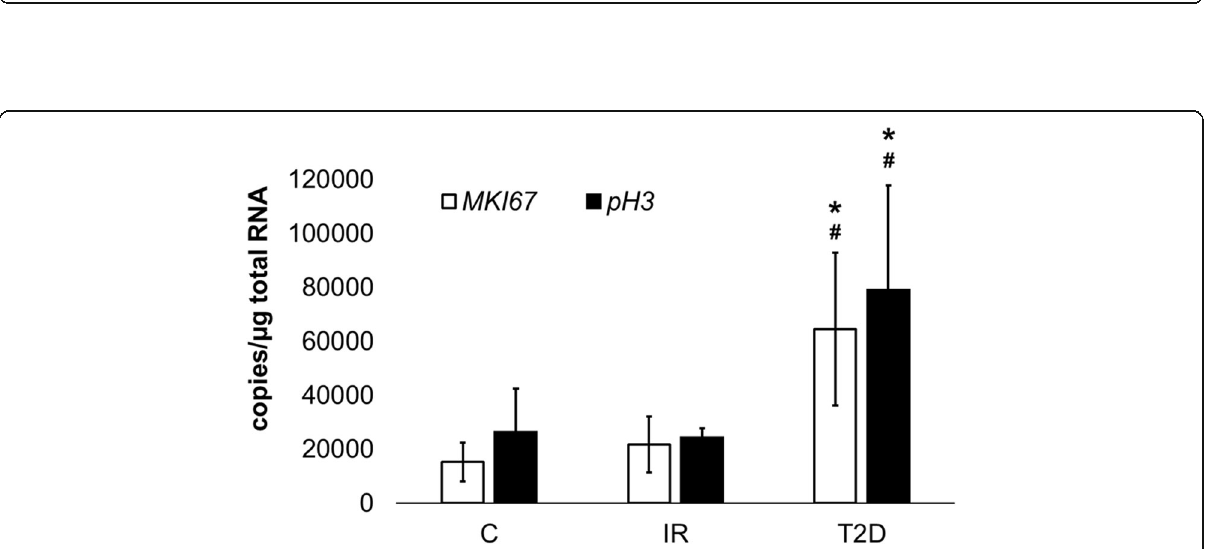
Fig. 2 The mRNA levels of MKI67 and pH 3 in the ADSC from patients with insulin-resistance (IR), diabetes mellitus type 2 (T2D) compared to control cells (C) from healthy people. The bars represent the means ± standard deviation (SD) of the copy numbers per 1 μ g of total RNA; ANOVA with the Tukey post hoc test * p < 0.05 vs. C, # p < 0.05 vs.